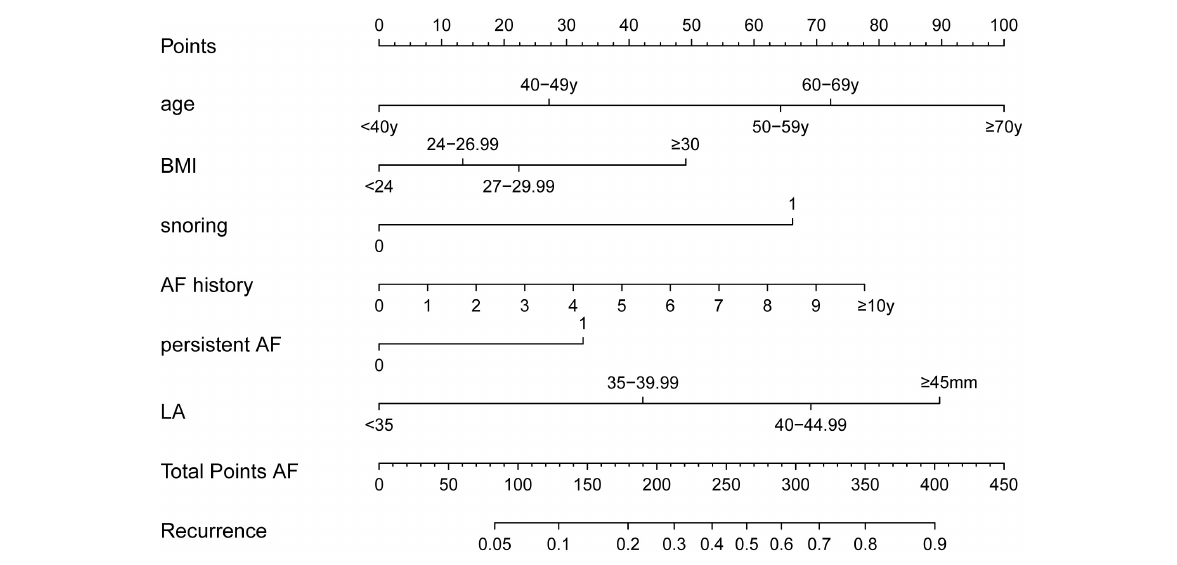
FIGURE1 Atrial fibrillation (AF) recurrence nomogram. The nomogram was developed in the development cohort. The total score of the nomogram was the sum of the corresponding score assigned to each risk factor, and the total score corresponds to the recurrence risk.